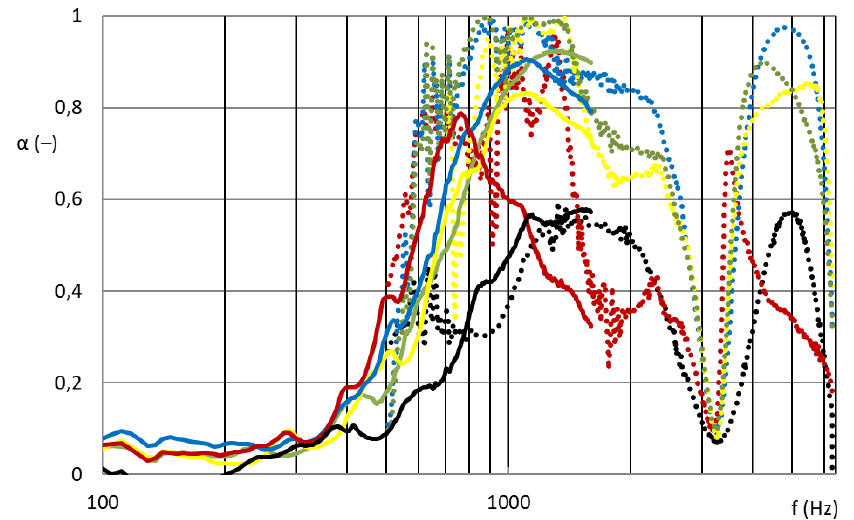
Figure 10. Sound absorption coefficient depending on sound frequency (100–6400 Hz). Solid curve: 100 mm diameter samples for frequency range 100–1600 Hz; dotted curve: 29 mm diameter samples for frequency range 500–6400 Hz. Ring R with nanofibrous membrane: blue: PVDF5; yellow: PVDF10; green: PVDF16; red: PVDF45; black: PA6022.